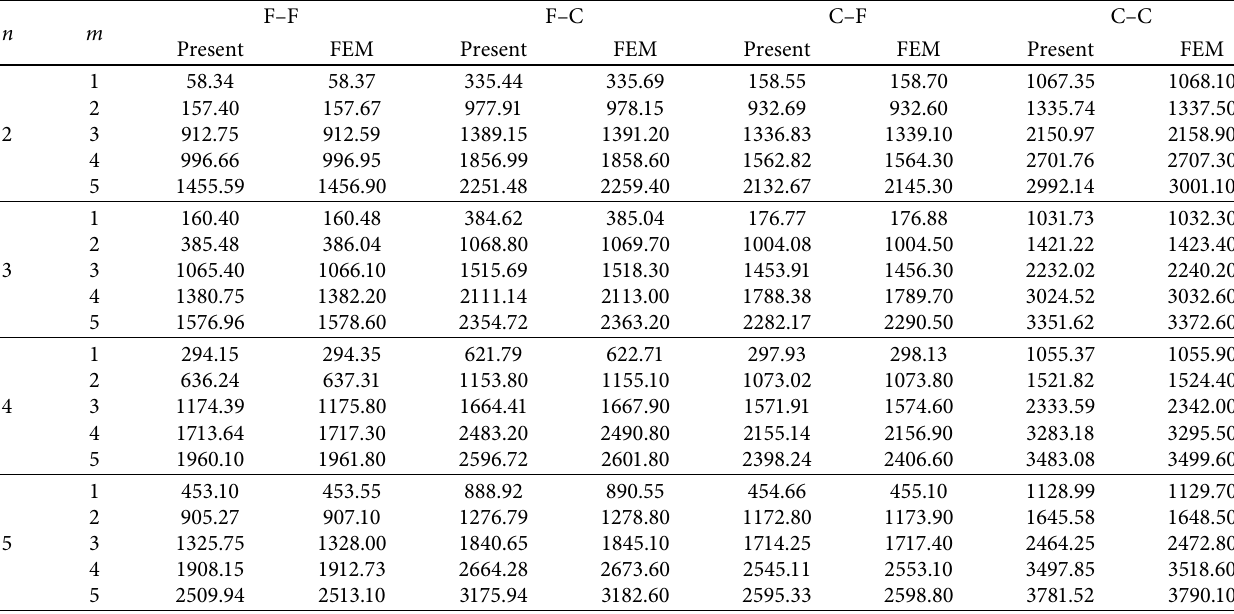
Table 2: Comparison of frequency for the annular spherical shell.